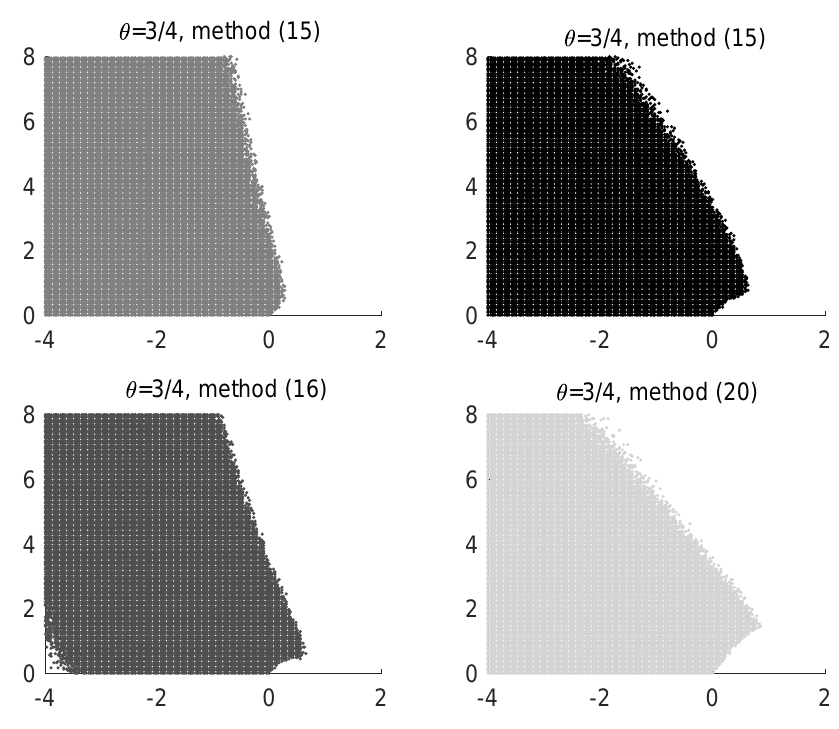
Figure 7. Asymptotic stability regions in the ( x , y )-plane with respect to the basic test Equation (11), case ϑ =